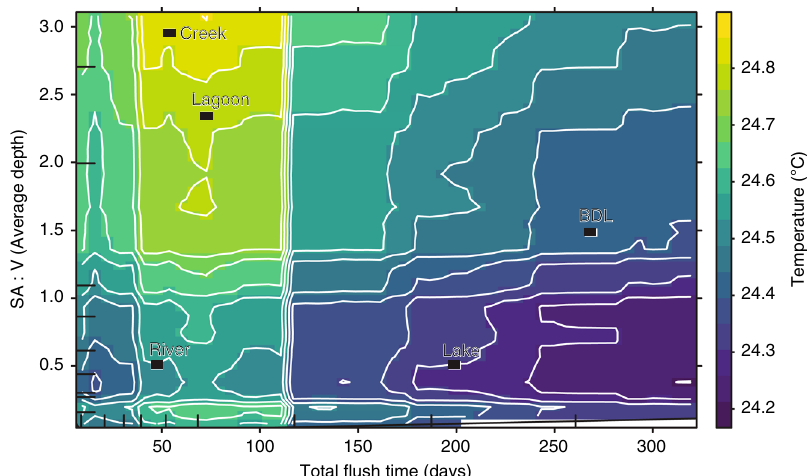
Fig. 3 Estuary temperature modelled using average depth and fl ushing time as predictors. Temperature as modelled by RF over a range of average depths and fl ushing times. Each estuary type is shown using its mean average depth and fl ushing time to indicate their general location in relation to these